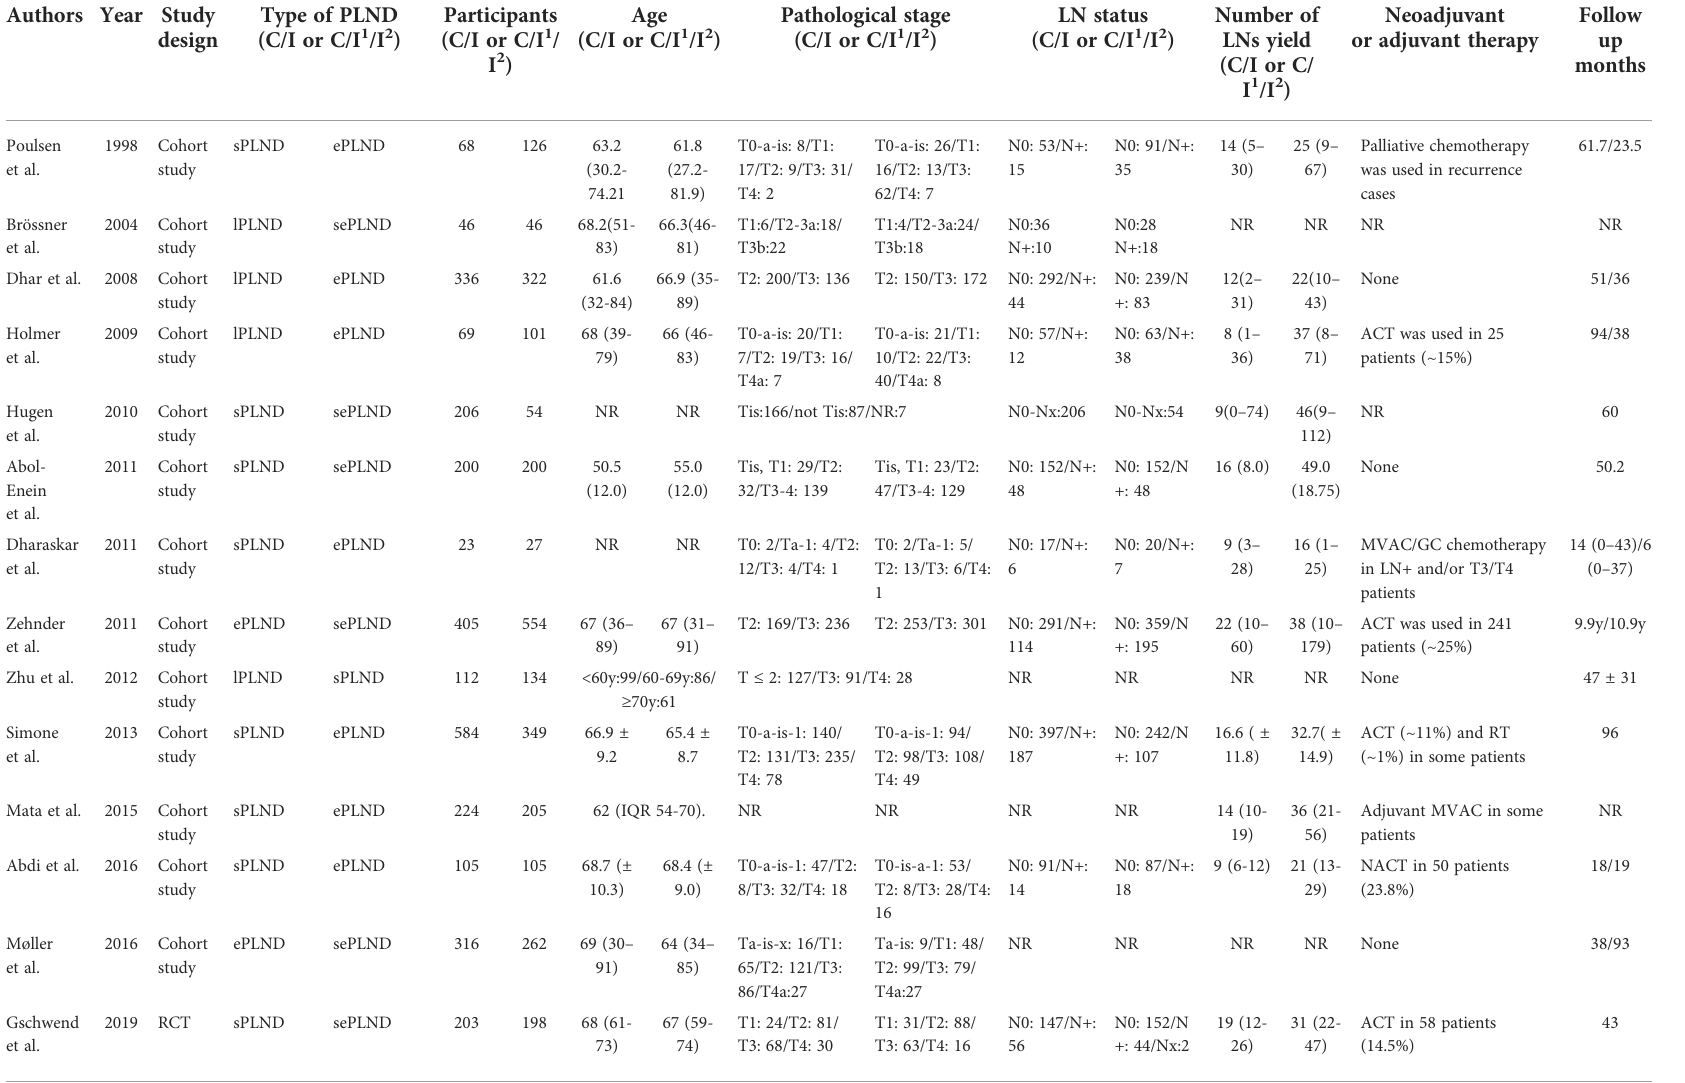
TABLE 1 Baseline characteristics of included